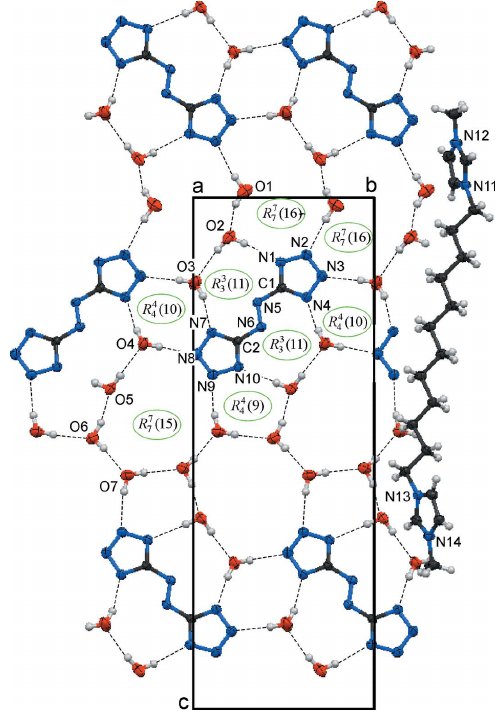
Figure 1 The arrangement of molecular entities in the crystal structure of the title compound, showing selected atom labels and displacement ellipsoids at the 50% probability level for non-H atoms. Hydrogen bonds are shown as dashed lines. Graph-set symbols indicate the hydrogen-bond patterns.